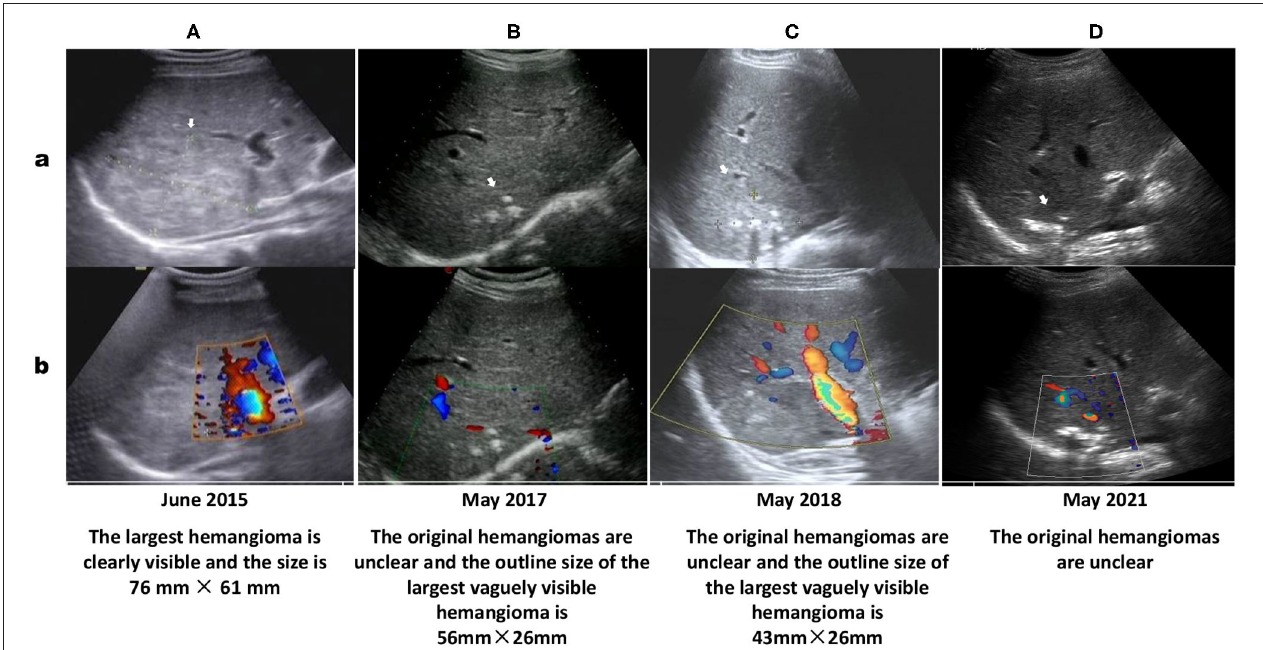
FIGURE 2 | Ultrasound showing multiple hemangiomas (white arrows) that appear as echogenic nodular lesions on grayscale ultrasound (a) and non-vascular lesions on color Doppler ultrasound (b). The size of the largest segment located in the S7 segment on US performed in June 2015 ( A : 76 × 61mm) is nearly as large as that on US performed in March 2013 (according to the US report without images, 75 × 62mm). Ultrasound images in May 2017 (B) , May 2018 (C) and May 2021 (D) show that most of the multiple hepatic hemangiomas are not clearly displayed, the largest hemangioma in the S7 segment is still visible (The size described in ultrasound report performed in May 2018 is 43 × 26mm), and calcified plaques can be seen